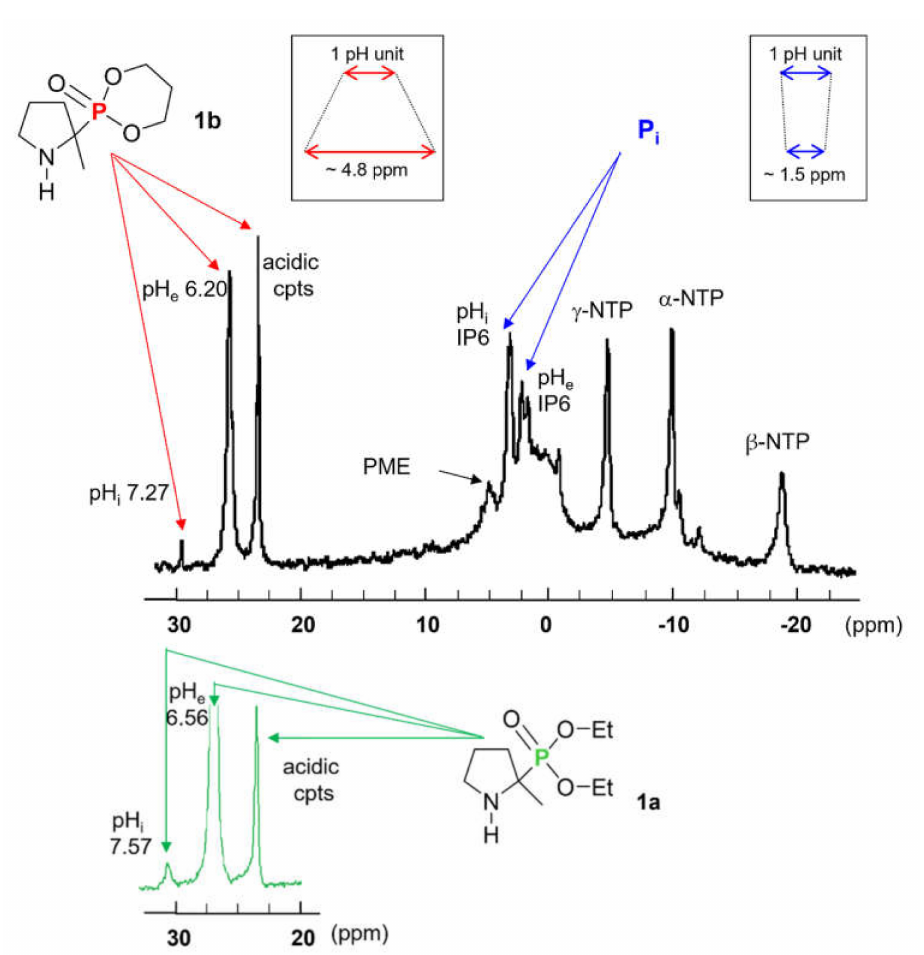
Figure 6. 31 P NMR spectra from D. discoideum cells (3 × 10 8 cells/mL) aerobically incubated at 20 ◦ C in the presence of 4 mM of 1b (upper trace) or 1a (green trace, only deshielded region shown). The signals correspond to a 15-min accumulation (900 scans) starting 15 min after addition of the